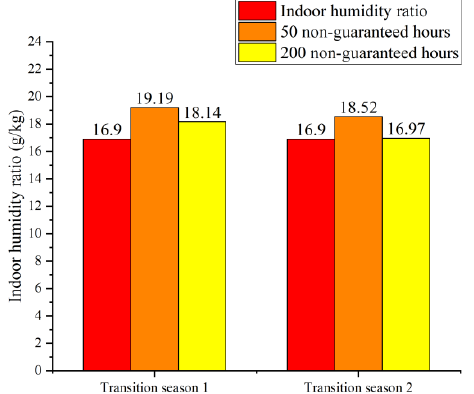
Figure 7. Comparison of indoor and outdoor humidity ratio.